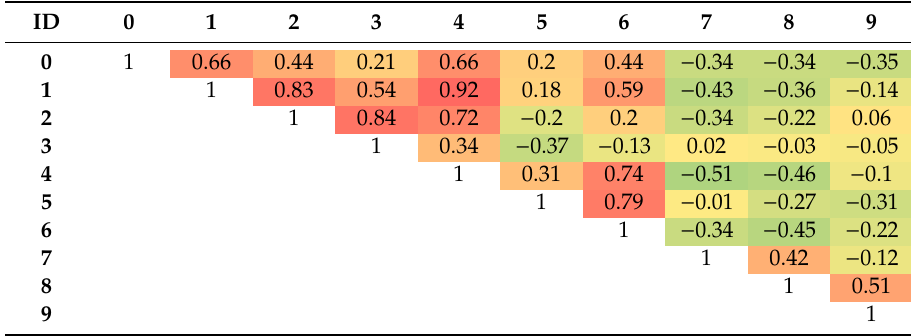
Table 2. Correlation table at study points around Bristol Bay from the H11 dataset.